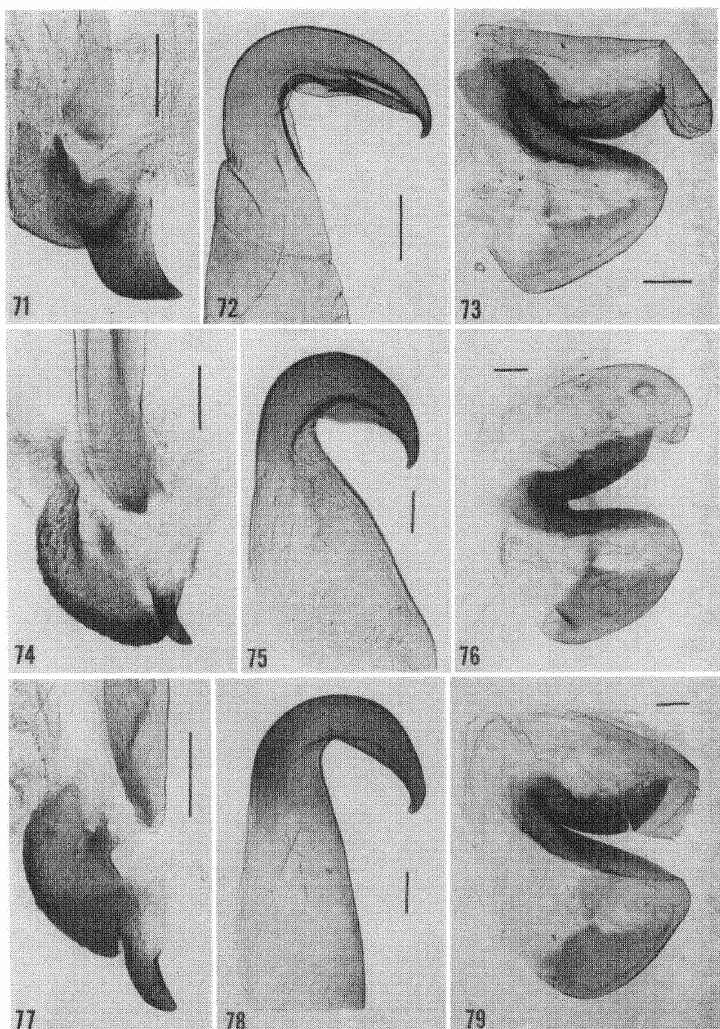
Figures 71-79. Male genital phallomeres of Blelharodera spp. 71-73. (1426 L). B. discoidalis (fro,m 6 shown in Fig. 45). 74-76. (34 CUZM). B. discoidalis (from 6 shown in Fig. 47). 77-79. (1425 L). B. ciliata (from 6 shown in Fig. 46). (scale--0.2